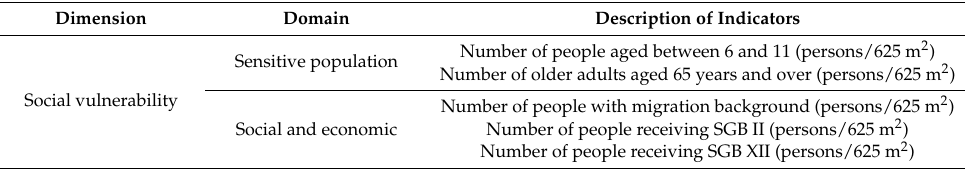
Table 3. Social indicators included in the index of social vulnerabiltiy.